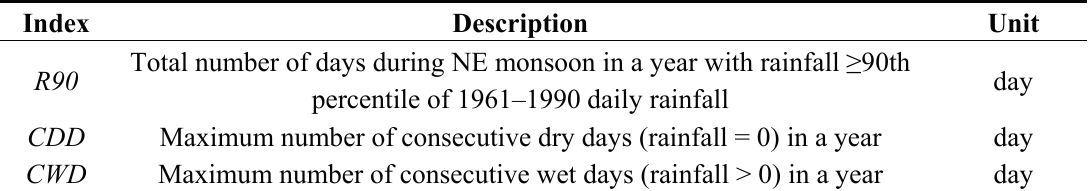
Table 1. Definitions of precipitation indices used in the present